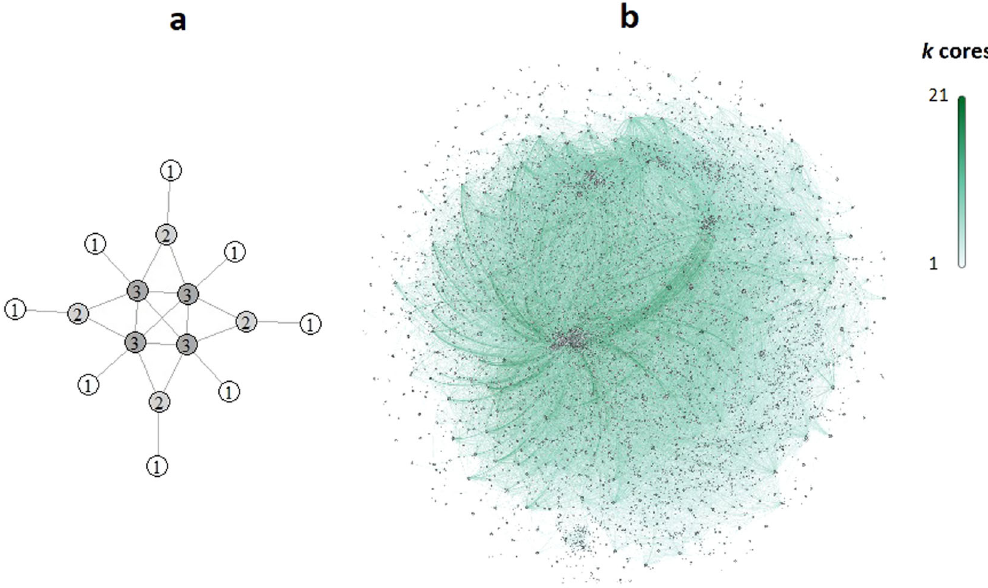
Fig. 1 Network core/periphery. a k core example. The numbers and colors re fl ect the maximum k value for each node. b The largest component in the Crimean retweet network. Nodes re fl ect pro fi les and edges re fl ect connections through retweets. Node size re fl ects indegree. Node color re fl ects maximum k -core. Nnodes = 134,170, Nedges = 199,581.